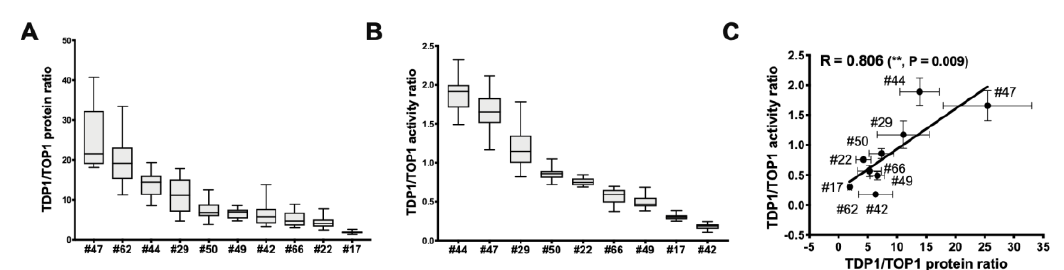
Figure 9. Range of TDP1 / TOP1 protein ratio and activity ratios in GBM patient tumor WCEs. The box plots show the median, with minimum and maximum values at the bottom and top tail-ends for ( A ) TDP1 / TOP1 protein ratio; ( B ) TDP1 / TOP1 activity ratio calculated from the relative TOP1, TDP1 protein and activity levels of each GBM patient tumor WCE; ( C ) Pearson correlation between the TDP1 / TOP1 protein ratio and TDP1 / TOP1 activity ratio.